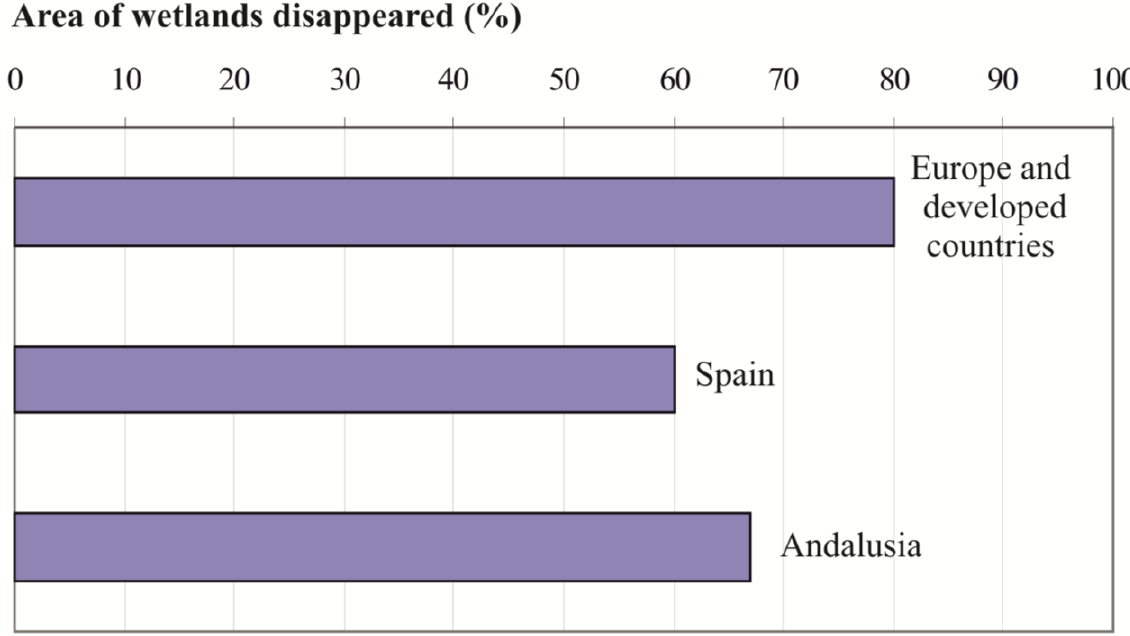
Figure 6. Estimates of the surface of wetlands cleared, according to different